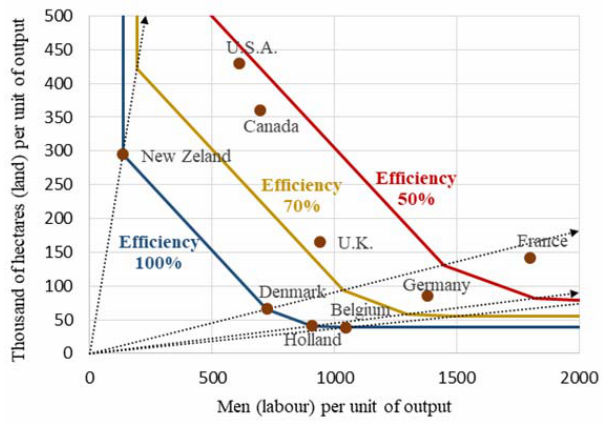
Figure 1: Application of the efficiency proposed by Farrell for agricultural production, adapted from